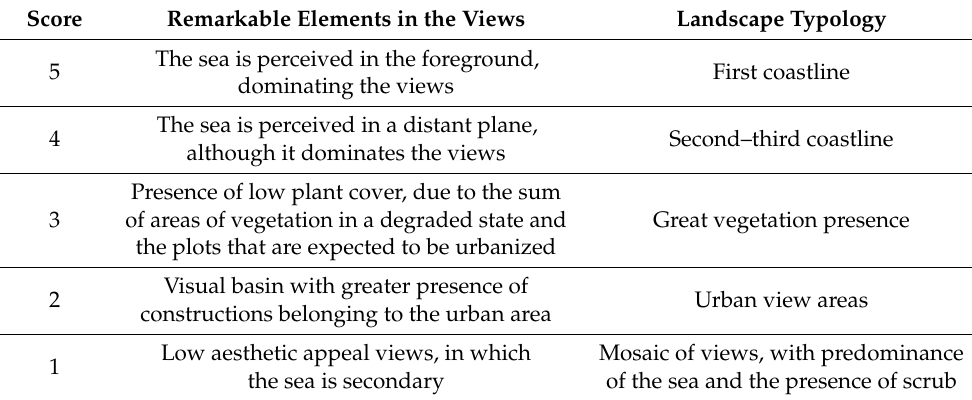
Table 2. Synthetic typologies of the